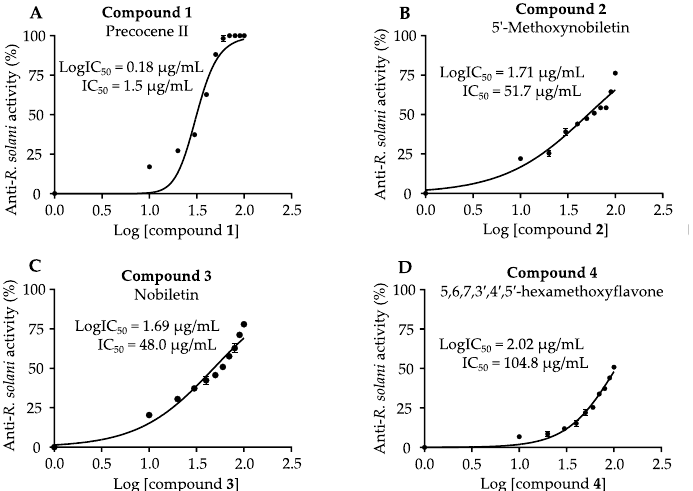
Figure 5. Antifungal activities of isolated compounds 1 – 5 ( A – D ) against the development of R. solani . R. solani was cultured for 1 day on PDA plates containing different concentrations of each compound from 10 to 250 µ g/mL. Then, the diameters of mycelial growth area of fungi were measured and IC 50 values were calculated. PI (%) calculated was plotted vs logarithmic concentration of the compound. n = 3.